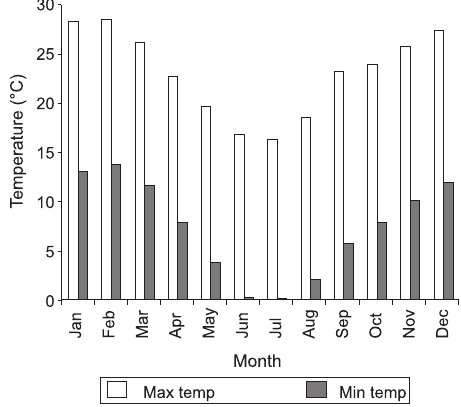
Fig. 3. The mean average minimum and maximum temperatures for Mountain Zebra National